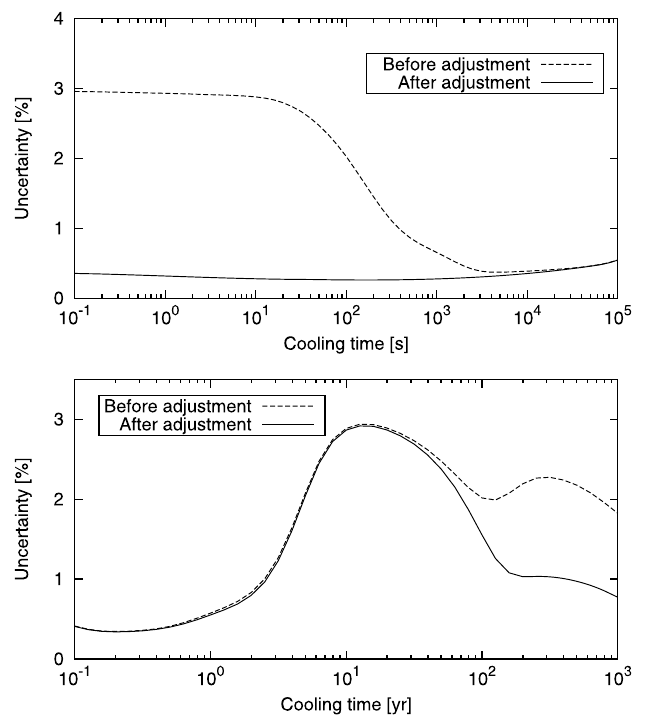
Fig. 4. Nuclear data-induced uncertainty of decay heat. The upper one is the short-term decay heat and the lower is the long- term